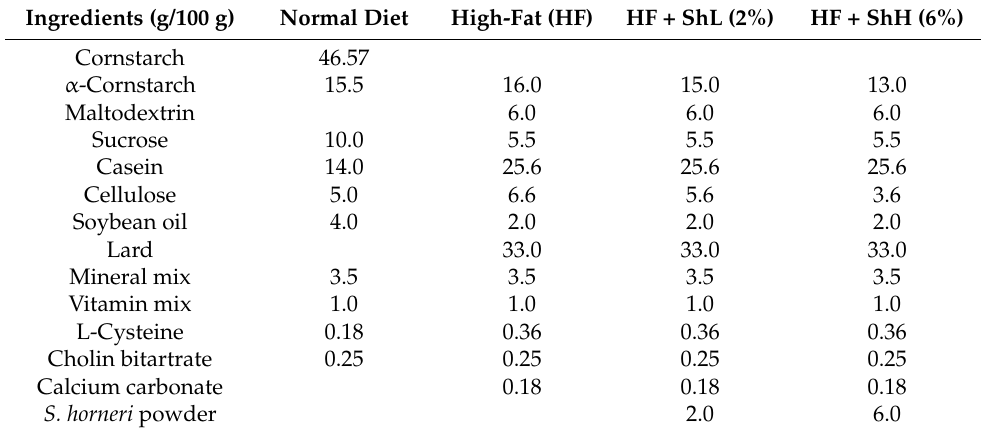
Table 1. Composition of the experimental